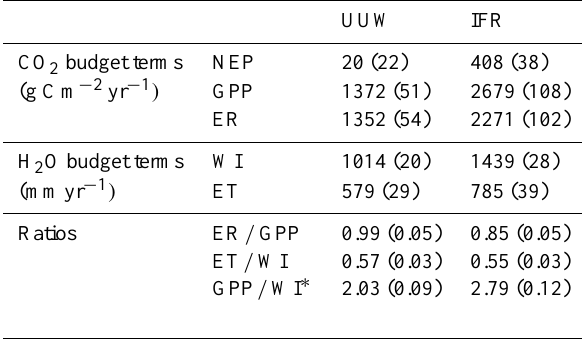
Table 1. Annual CO 2 budget and water budget terms and their ratios for the UUW pasture (unirrigated, unfertilised, winter-grazed) and the IFR pasture (irrigated, fertilised, rotationally grazed). Estimated uncertainties are given in